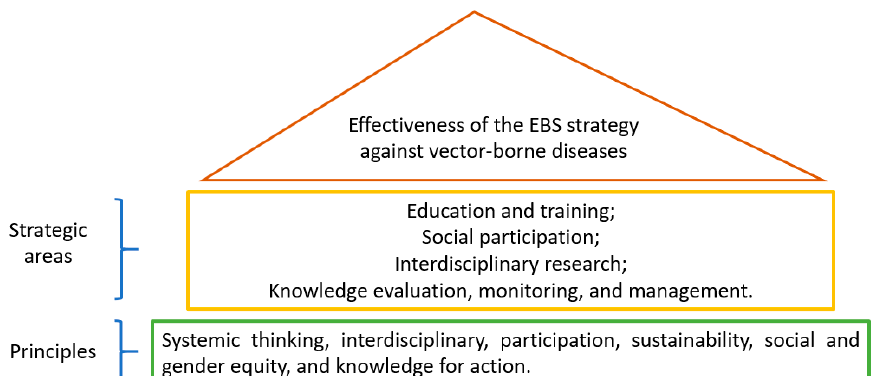
Figure 1. Principles and strategic areas of action of the Eco-Bio-Social (EBS) strategy.